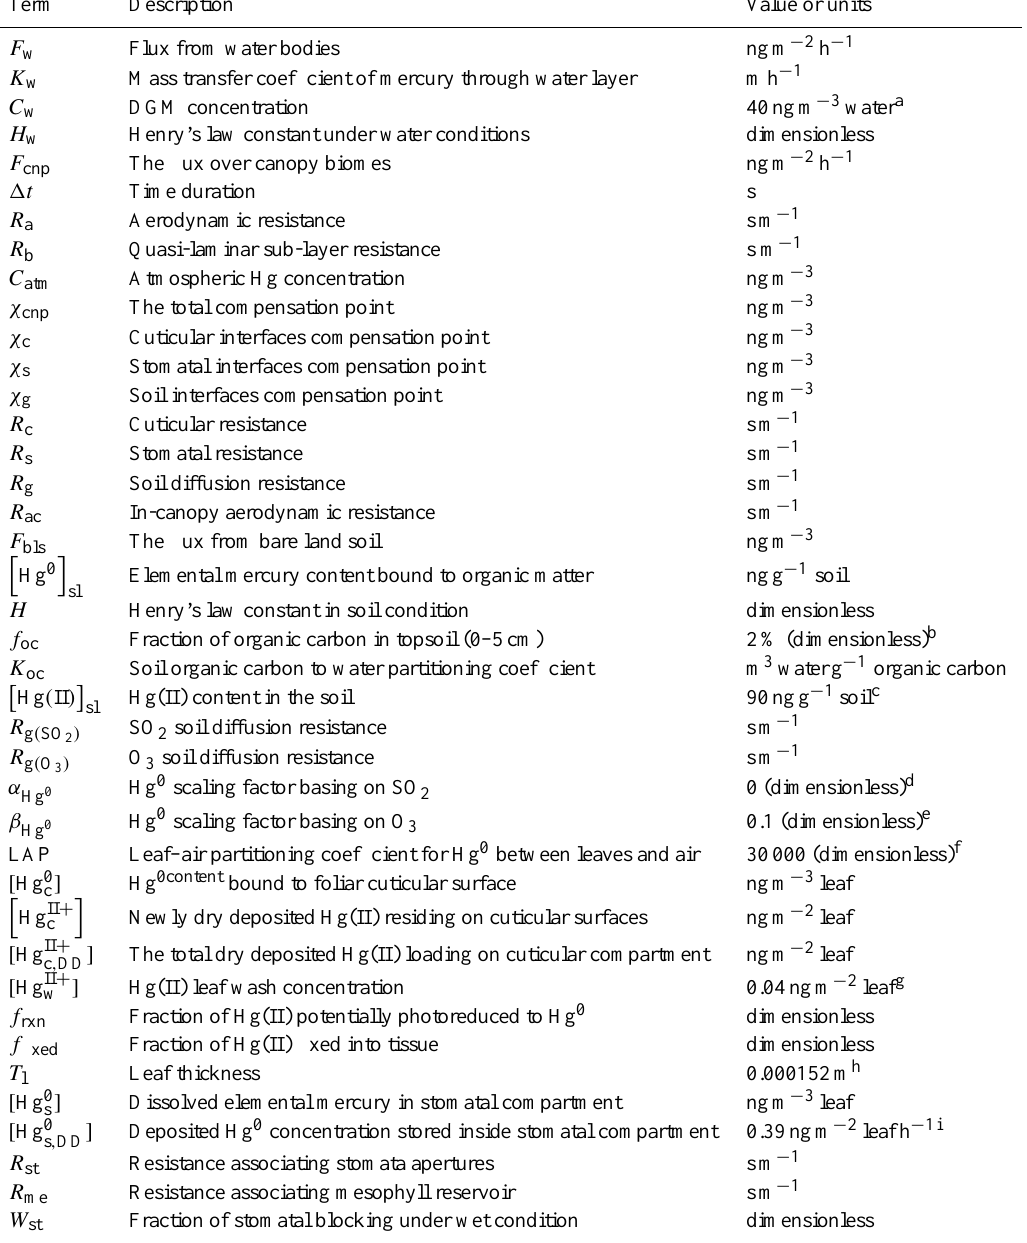
Table 1. Model variables and units in the base-case simulation.